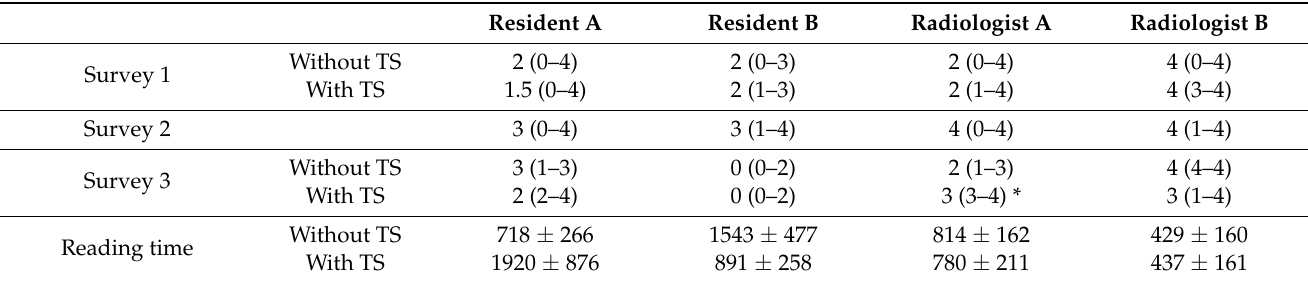
Table 3. The scores for each survey and the reading